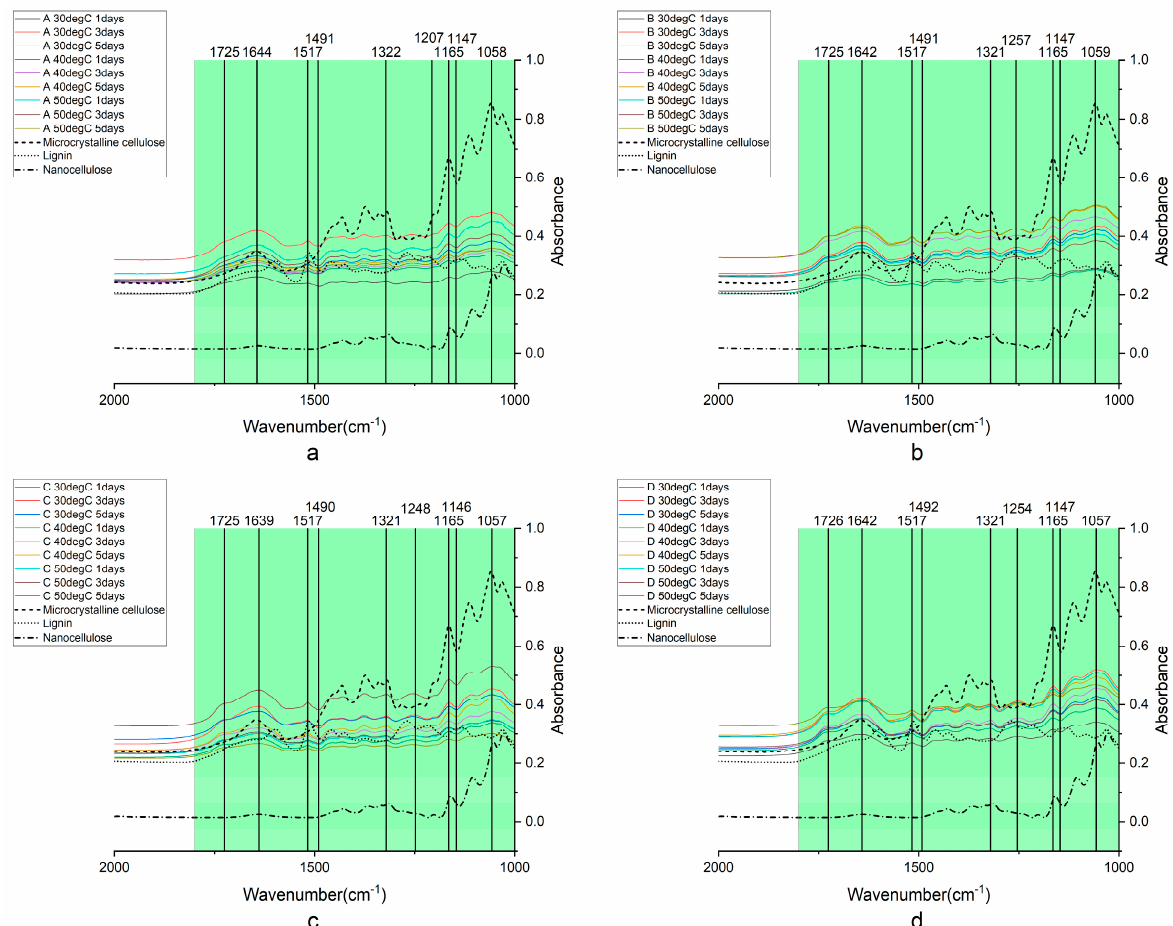
Figure 10. FTIR spectra of leaf samples pretreated at 75 ◦ C at varying incubation temperatures and